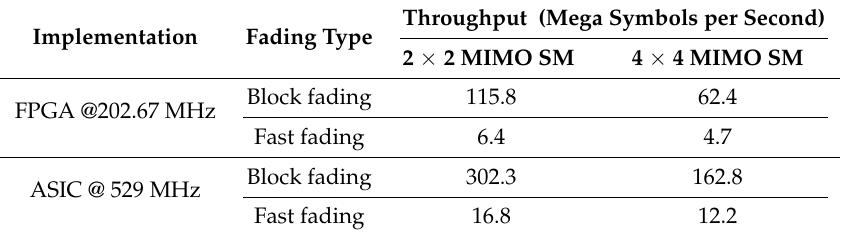
Table 3. Throughput of the proposed NISC-based equalizer architecture. SM,